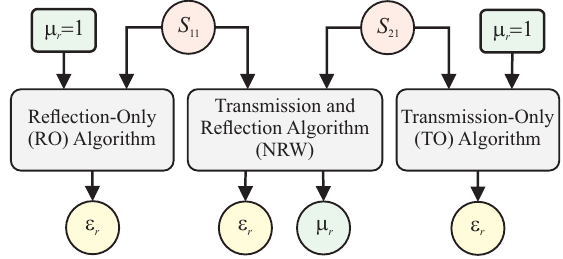
Figure 2. Extraction of the permittivity ε r and permeability µ r from the S-Parameters S 11 and S 21